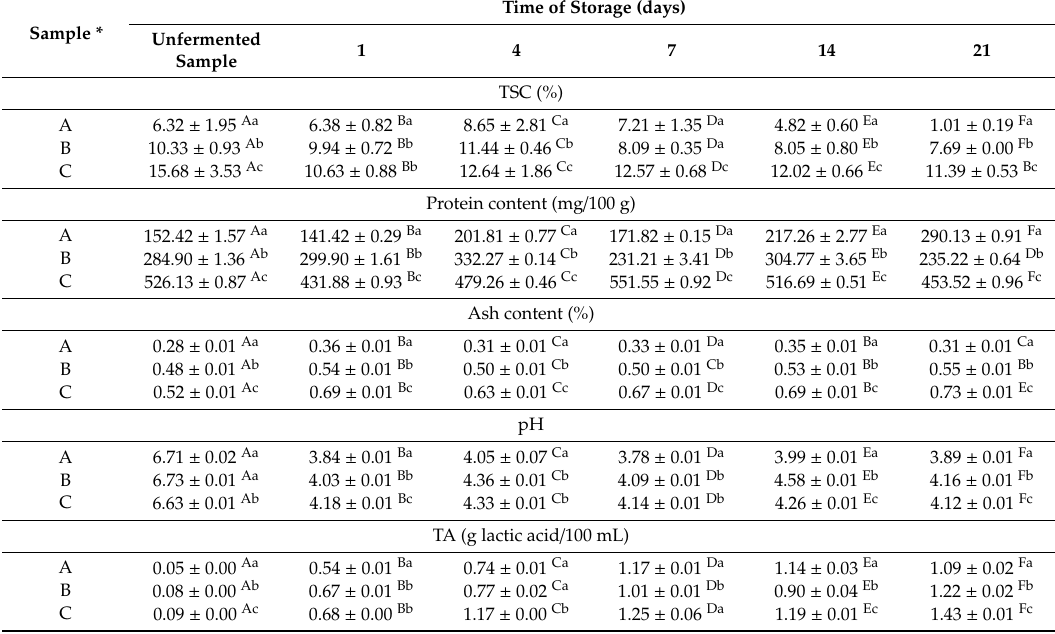
Table 1. Total solids content (TSC), protein content, ash content, pH, and titrable acidity (TA) of fermented beverages and unfermented (control)